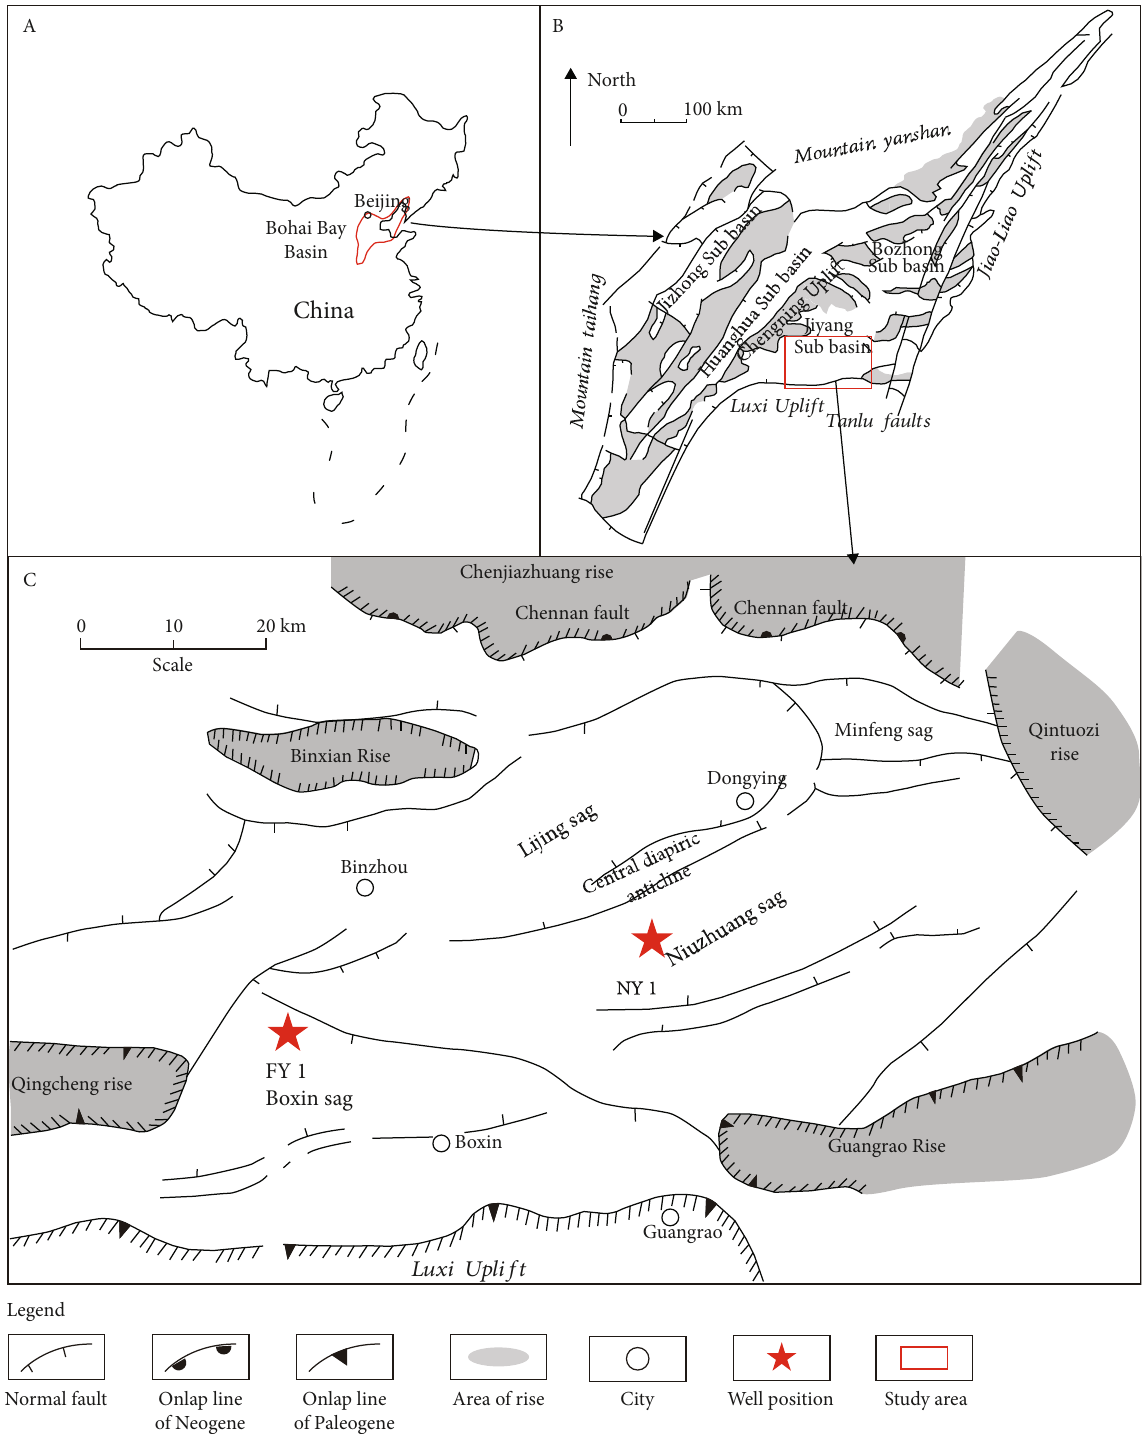
Figure 1: Location and tectonic setting of the Bohai Bay Basin (a, b) and Dongying Depression